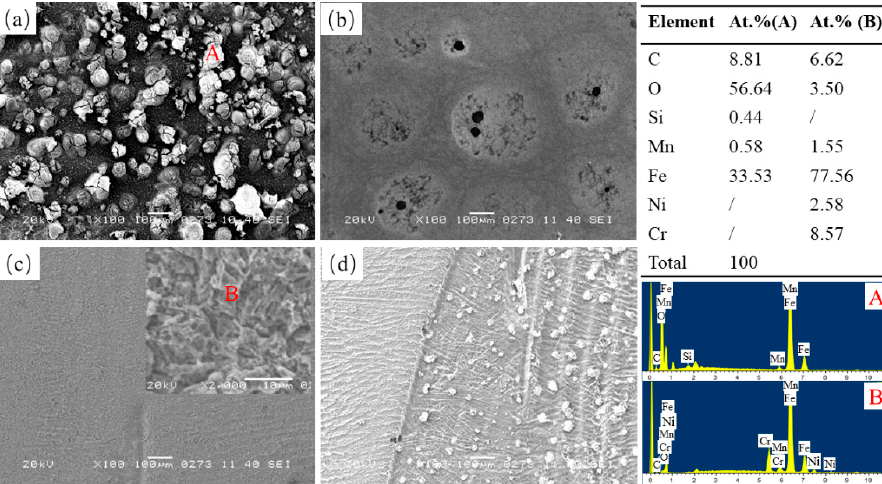
Figure 10. SEM images of corrosion products formed on the surface of samples 1, 2, 3 an 4 after corrosion in 3.5% NaCl. ( a – d ) are samples 1, 2, 3, and 4, respectively.